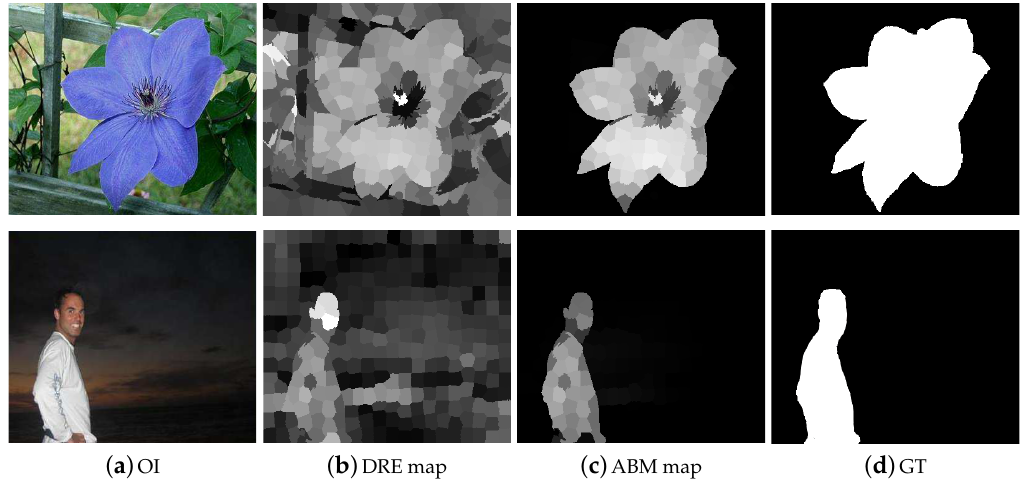
Figure 4. The validity of obtaining a background coefficient matrix is noticeable from the demonstrated results. The results are arranged as OI, the dense representation error map, ABM map, and the